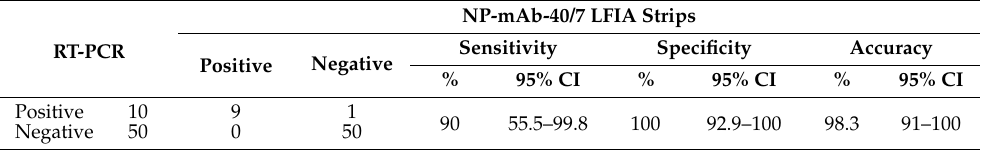
Table 4. Clinical performance of the NP-mAb-40/7 LFIA